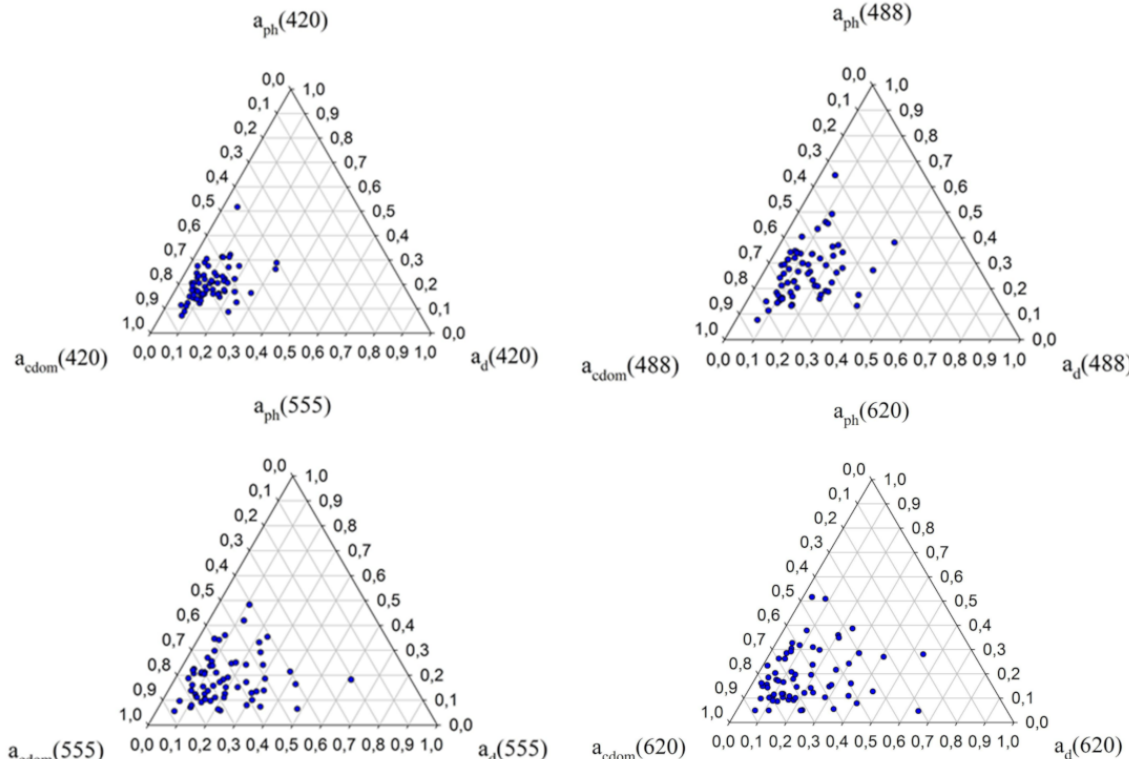
Figure 4. Ternary plots of the relative contribution of CDOM ( a CDOM ), non-phytoplankton pigments ( a d ) and phytoplankton pigments ( a ph ) to total absorption by non-water constituents at four wave- lengths in the selected areas of the southern Baltic. The relative contribution of a given component was calculated as the ratio of the absorption coefficient of that component (e.g., a ph ( λ i )) and the sum of the absorption coefficients of all three components [ a CDOM ( λ i ) + a d ( λ i ) + a ph ( λ i